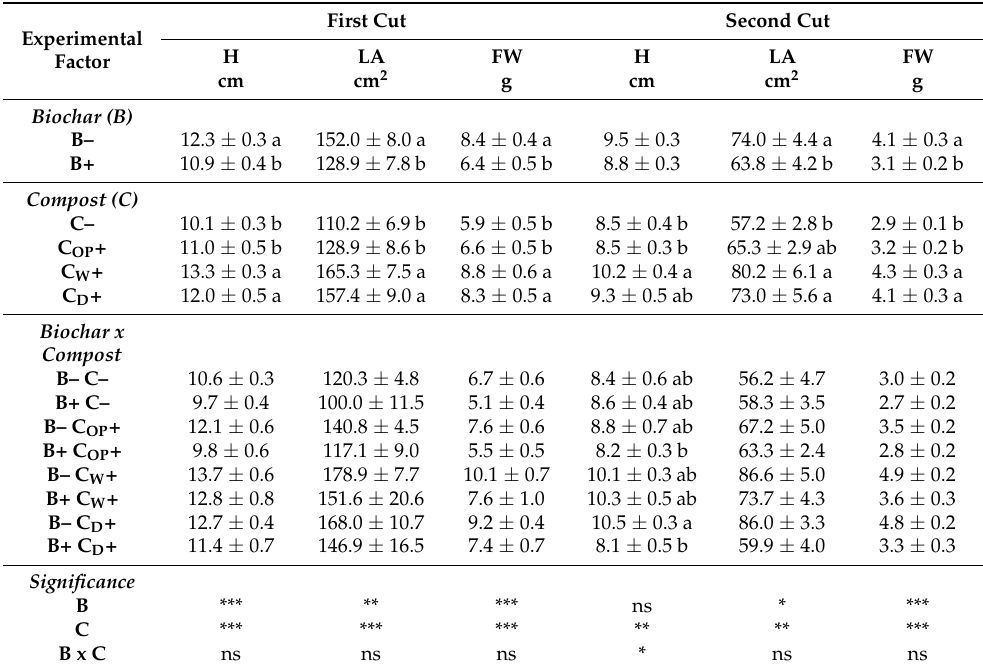
Table 3. Effect of biochar, compost and biochar x compost interaction on plant height (H), leaf area (LA), and leaf fresh weigh (FW), at the first and second cut of Swiss chard. First Cut Second Cut Experimental H LA FW Factor cm cm 2